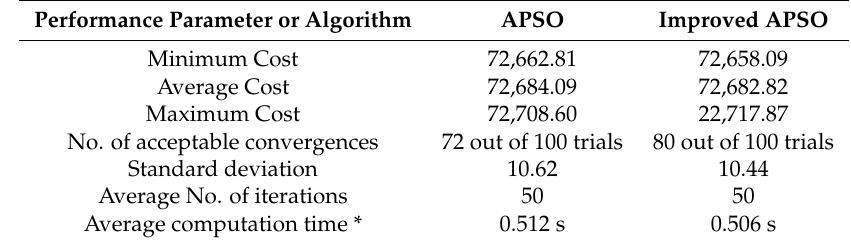
Table 15. Comparison of some performance parameters between APSO and improved APSO on the non-cascaded and non-pumped storage STHTS problem while not considering transmission